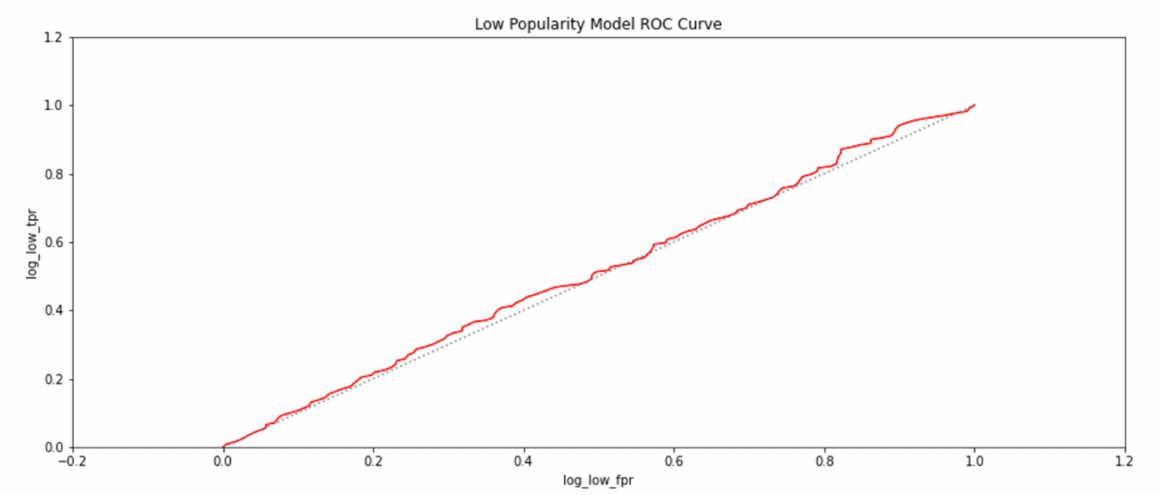
Figure 17. The probability of an exhibit area being in a less popular category as identified by a logistic regression- based